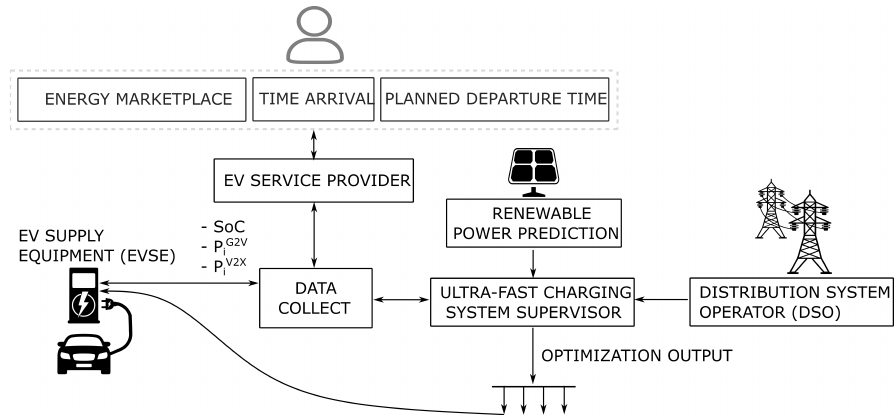
Figure 2. Fast charging integration with the